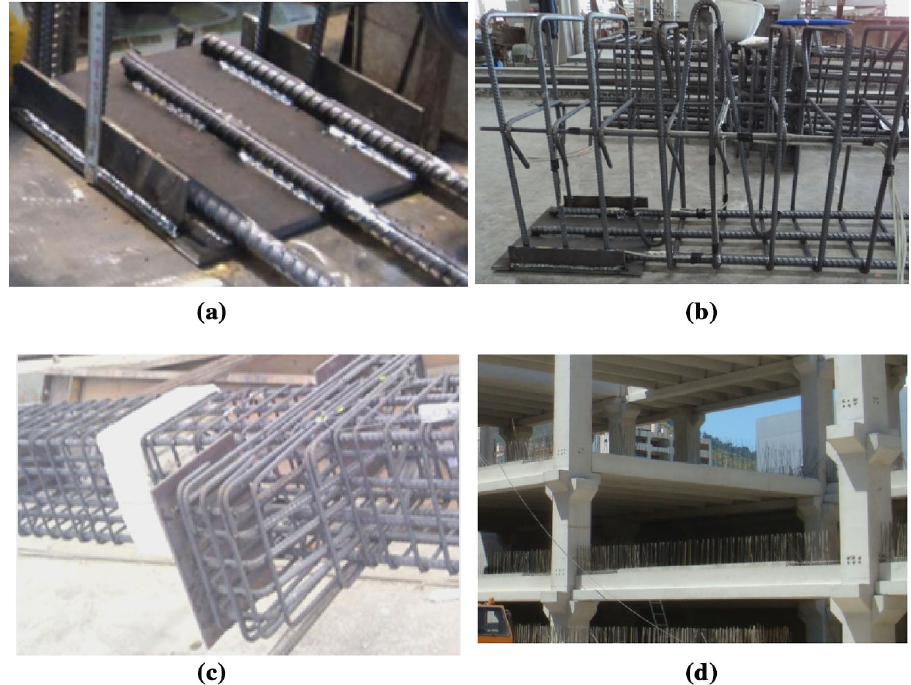
Fig. 1 A precast structure under construction with hybrid beam-column connections. a Welding of longitudinal beam bottom rebars to beam end plate. b Installation of flexural and shear reinforcement for a precast beam. c Installation of flexural and shear reinforcements to constitute the precast column and corbels. d Assembling precast beam and column elements on